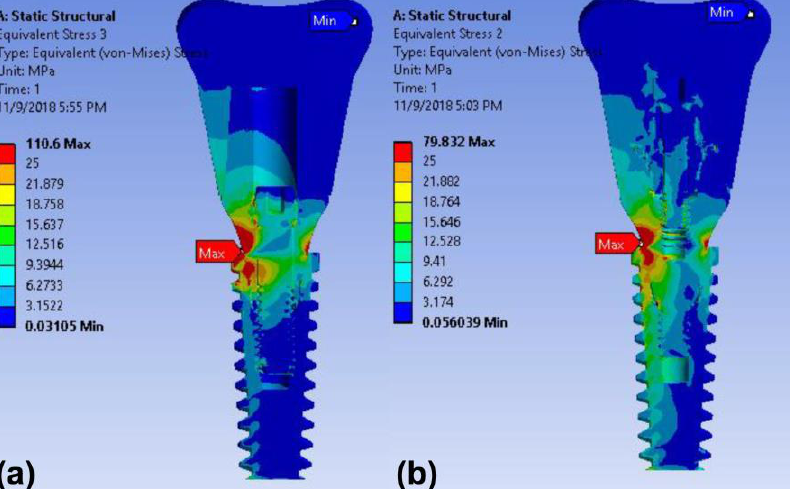
Figure 7. Color-coded von Mises stress distributions in the surrounding bone and implant under oblique load in the finite element model: ( a ) cement-retained and ( b ) cementless screw-retained zirconia crown models.